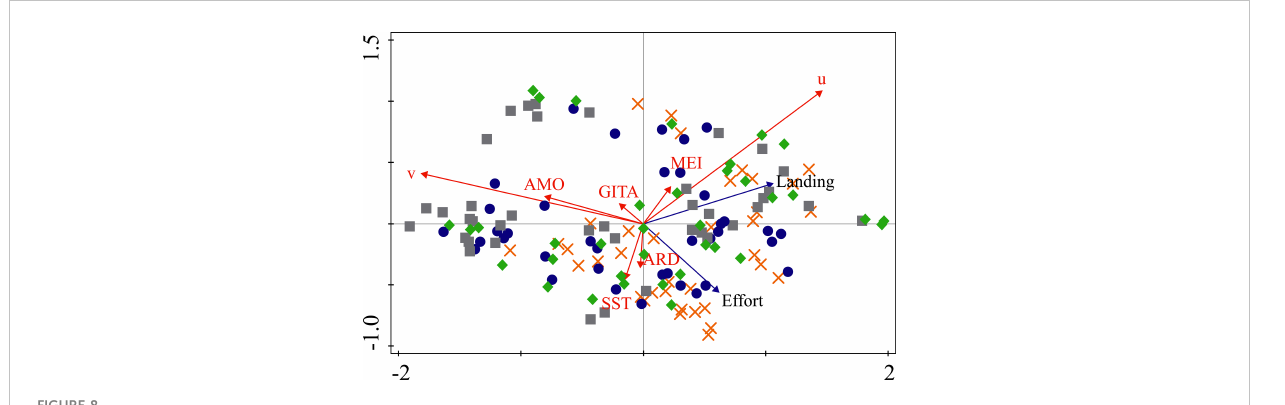
FIGURE 8 Results of the Redundancy Analysis (RDA) of the shark bycatch landed by the acoupa weak fi sh ( Cynoscion acoupa ) gillnet fi sheries and the environmental variables. The dark blue arrows indicate the shark bycatch, while the red arrows represent the environmental variables considered in the present study. Categorical variables: hydrological cycle of the Amazon River: wet, fl ood, ebb, and dry. Environmental variables: Amazon River Discharge (ARD); zonal and meridional wind components (u, v), Sea Surface Temperature (SST); Atlantic Ocean Inter-hemispheric Sea Surface Temperature Gradient Index (GITA), and Multivariate El Niño Index (MEI). Symbols: orange x = wet; dark blue circle = fl ood; gray square = ebb, and green diamond =